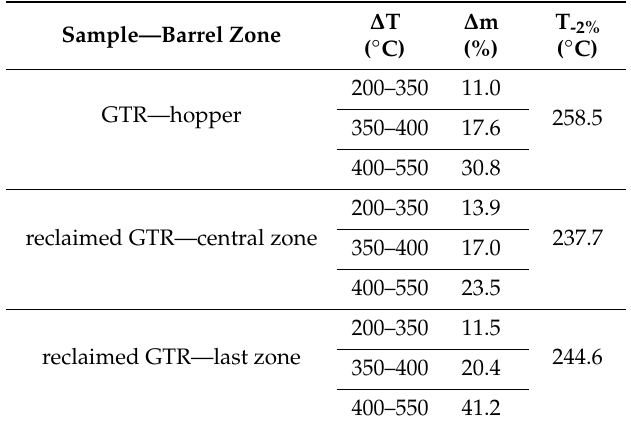
Figure 5. The appearance of: ( A ) open extruder barrel after stopping of reclaiming process ( B ) GTR collected from di ff erent zones of the extruder barrel. Table 4. Mass loss ( ∆ m) as a function of the temperature range ( ∆ T) and T -2% from TGA curves for reclaimed GTR collected from di ff erent zones of the extruder